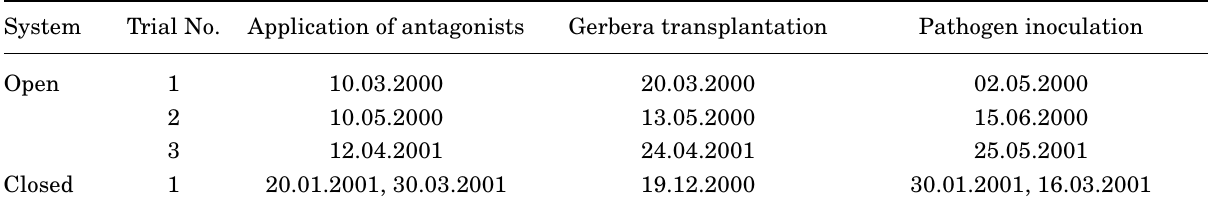
Table 1. Dates of gerbera transplantation, applications of the antagonists and pathogen inoculations in the open and closed soilless system trials (Albenga, 2000–2001). System Trial